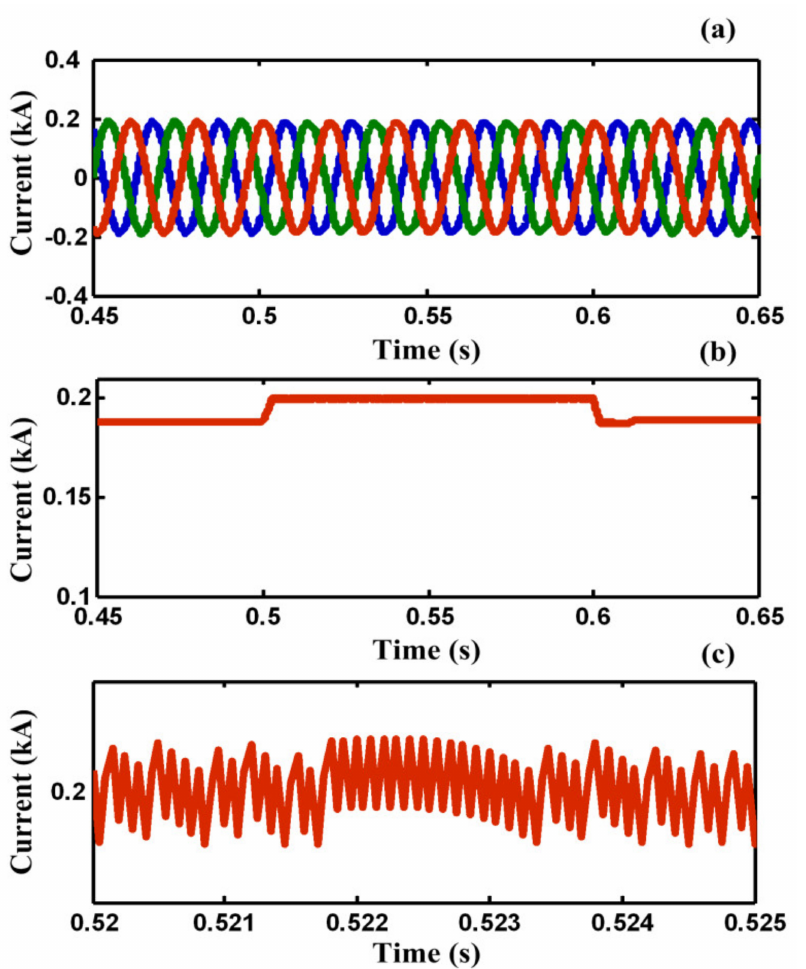
Figure 12. ( a ) The current of common loads in F 1 , ( b ) SC coil current, ( c ) enlargement SC coil current during fault in case